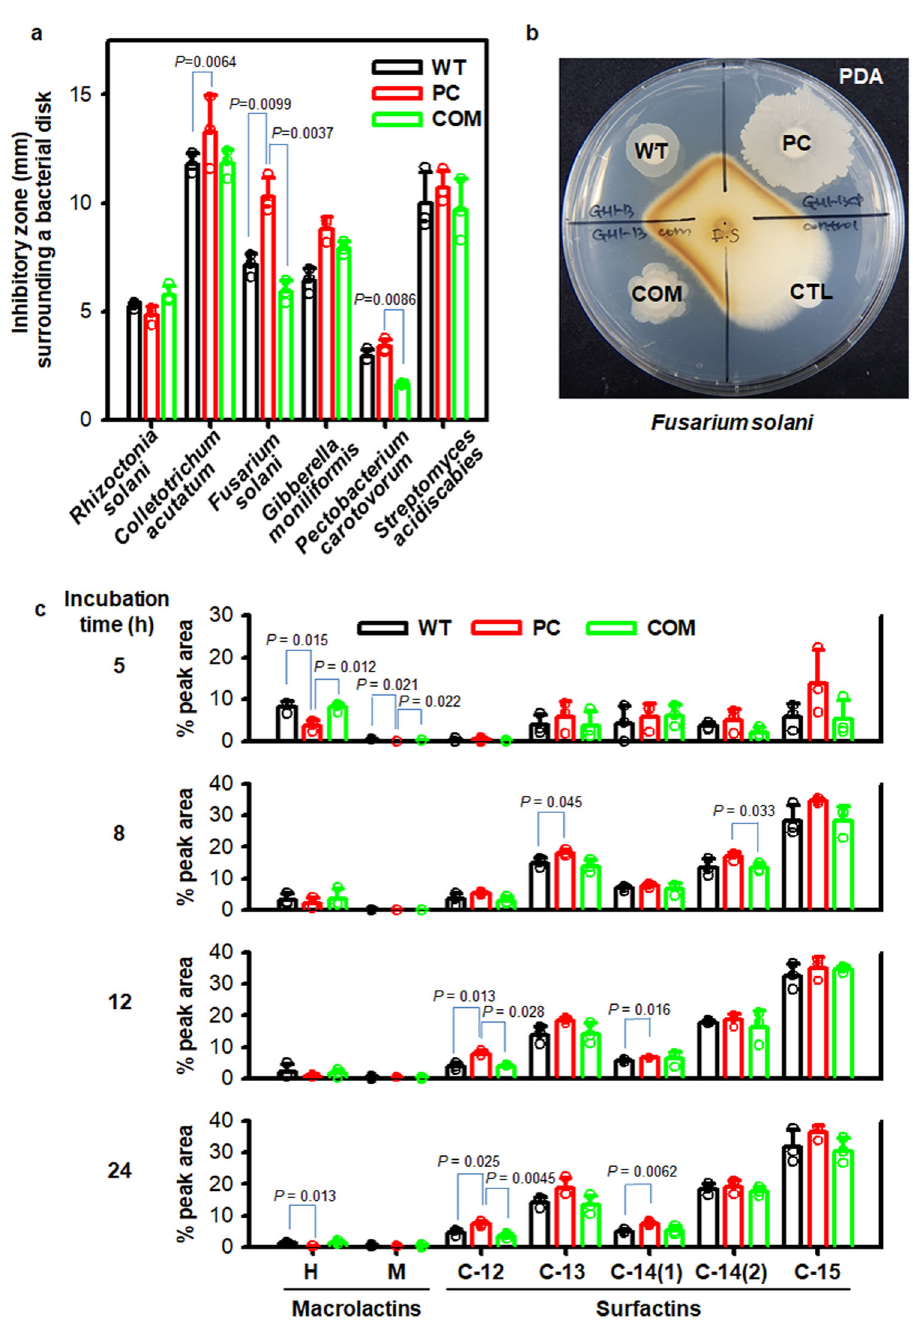
Fig. 7 Antagonistic test and analysis of antibiotics released from strain GH1-13. a In vitro inhibition of plant pathogens tested as shown in Supplementary Fig. 6. b A typical photo of Fusarium solani tested in vitro by bacterial disk assays of wild-type (WT or W), plasmid-cured (PC or P), and complemented (COM or C) cells on a potato dextrose agar (PDA) plate. c Levels of macrolactins ( H and M ) and surfactins ( C12 to C15 ) in the fi ltered culture fl uids when cells were grown in tryptic soy broth at 25 °C and 180 rpm. The chemical properties and structures determined by HPLC with UV spectroscopy and mass spectrometry are shown in Supplementary Fig. 7. Statistically signi fi cant differences in the percentage of each peak area between strains at the incubation times of 5, 8, 12, and 24 h were determined by two-tailed t -tests with P -values of less than 0.05. n = 3 independent experiments (Supplementary Data 3). The mean and standard deviation (error bar) are plotted for all